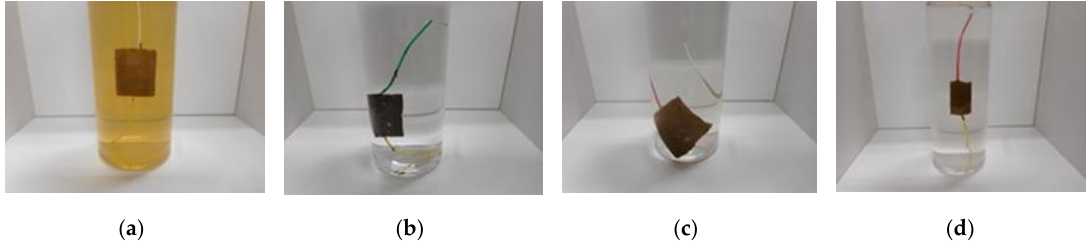
Figure 13. Images of the MCF rubber sensor immersed in water; ( a ) with TiO 2 and without PDMS and PVA; ( b ) without TiO 2 , and with PDMS and PVA; ( c ) with TiO 2 , PDMS and PVA; ( d ) without TiO 2 , with PDMS and PVA, and infiltrated with glycerin; all rubbers include MF (W-40) + Ni + NR-latex (Ulacol) + CR-latex (671A) with an applied magnetic field.